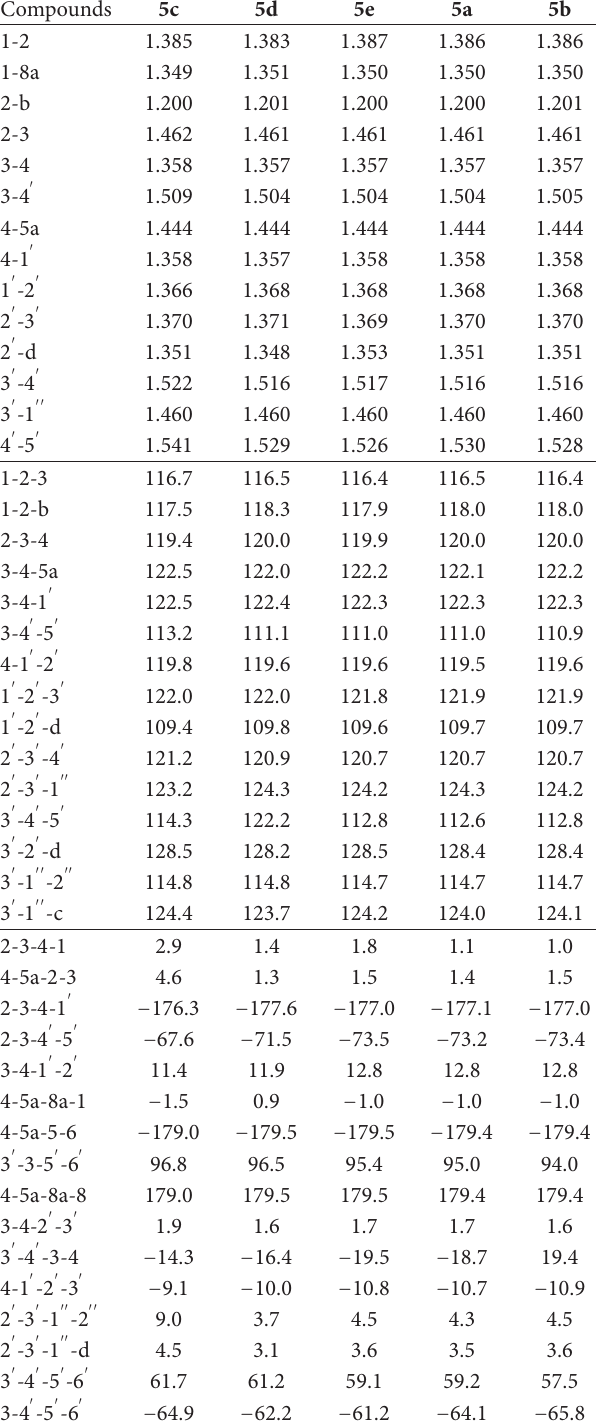
T 2: eoretical and experimental vibrational frequencies ) and theoretical infrared intensities (kmmol (cm − 1